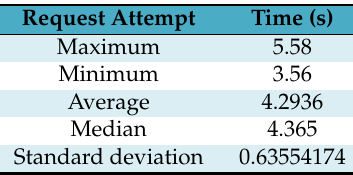
Table 6. Most prominent figures obtained from periodic data subscription